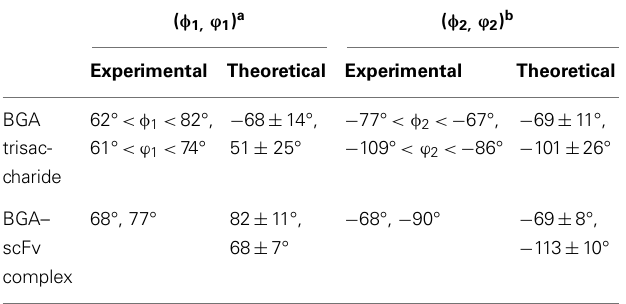
Table 1 | Comparison of glycosidic torsion angles between experimentally observed values and average values obtained from the MD simulations .